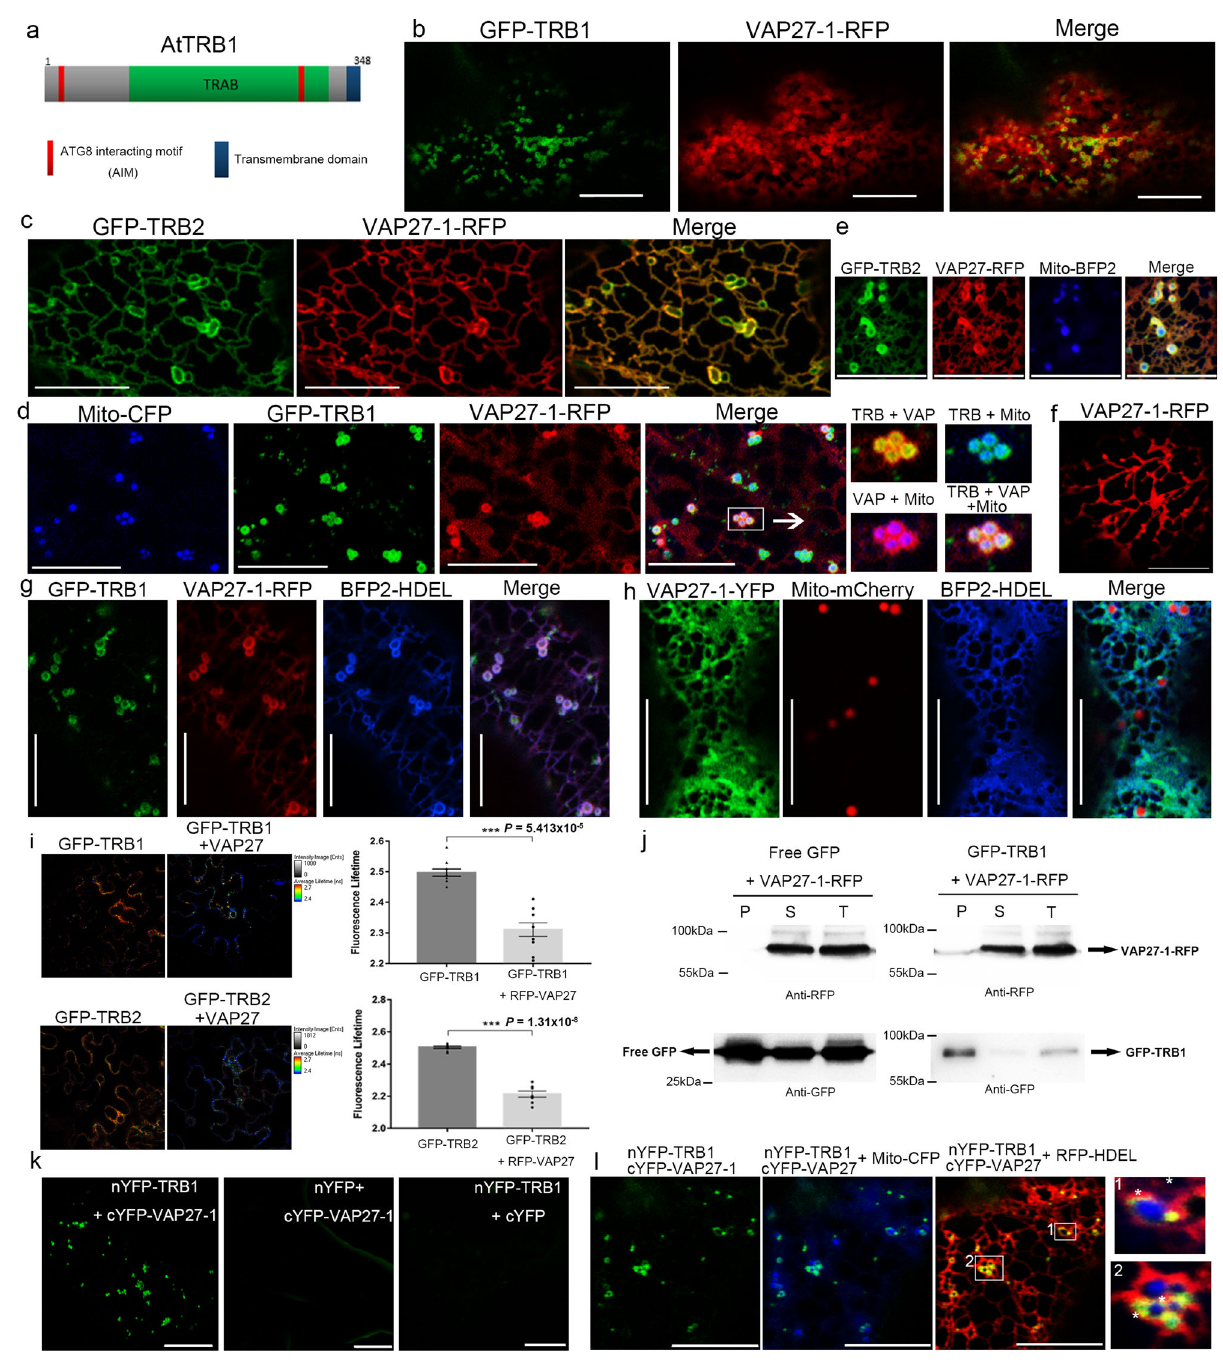
Fig. 1 | TRB1 and TRB2 proteins interact with VAP27 at ER-mitochondrial interface. a Schematic illustration of TRB1 protein in Arabidopsis; it contains